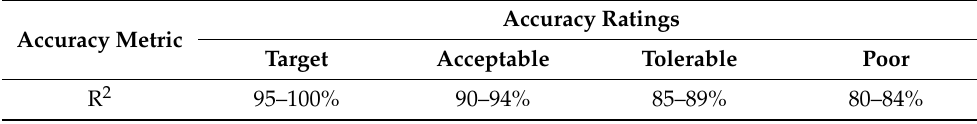
Table 3. Proposed accuracy requirements for virtual sensor-based nutrient